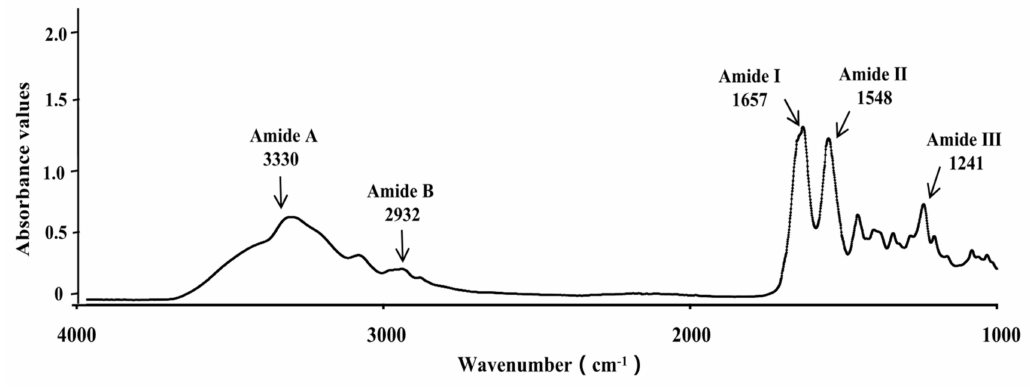
Figure 3. FTIR spectra of